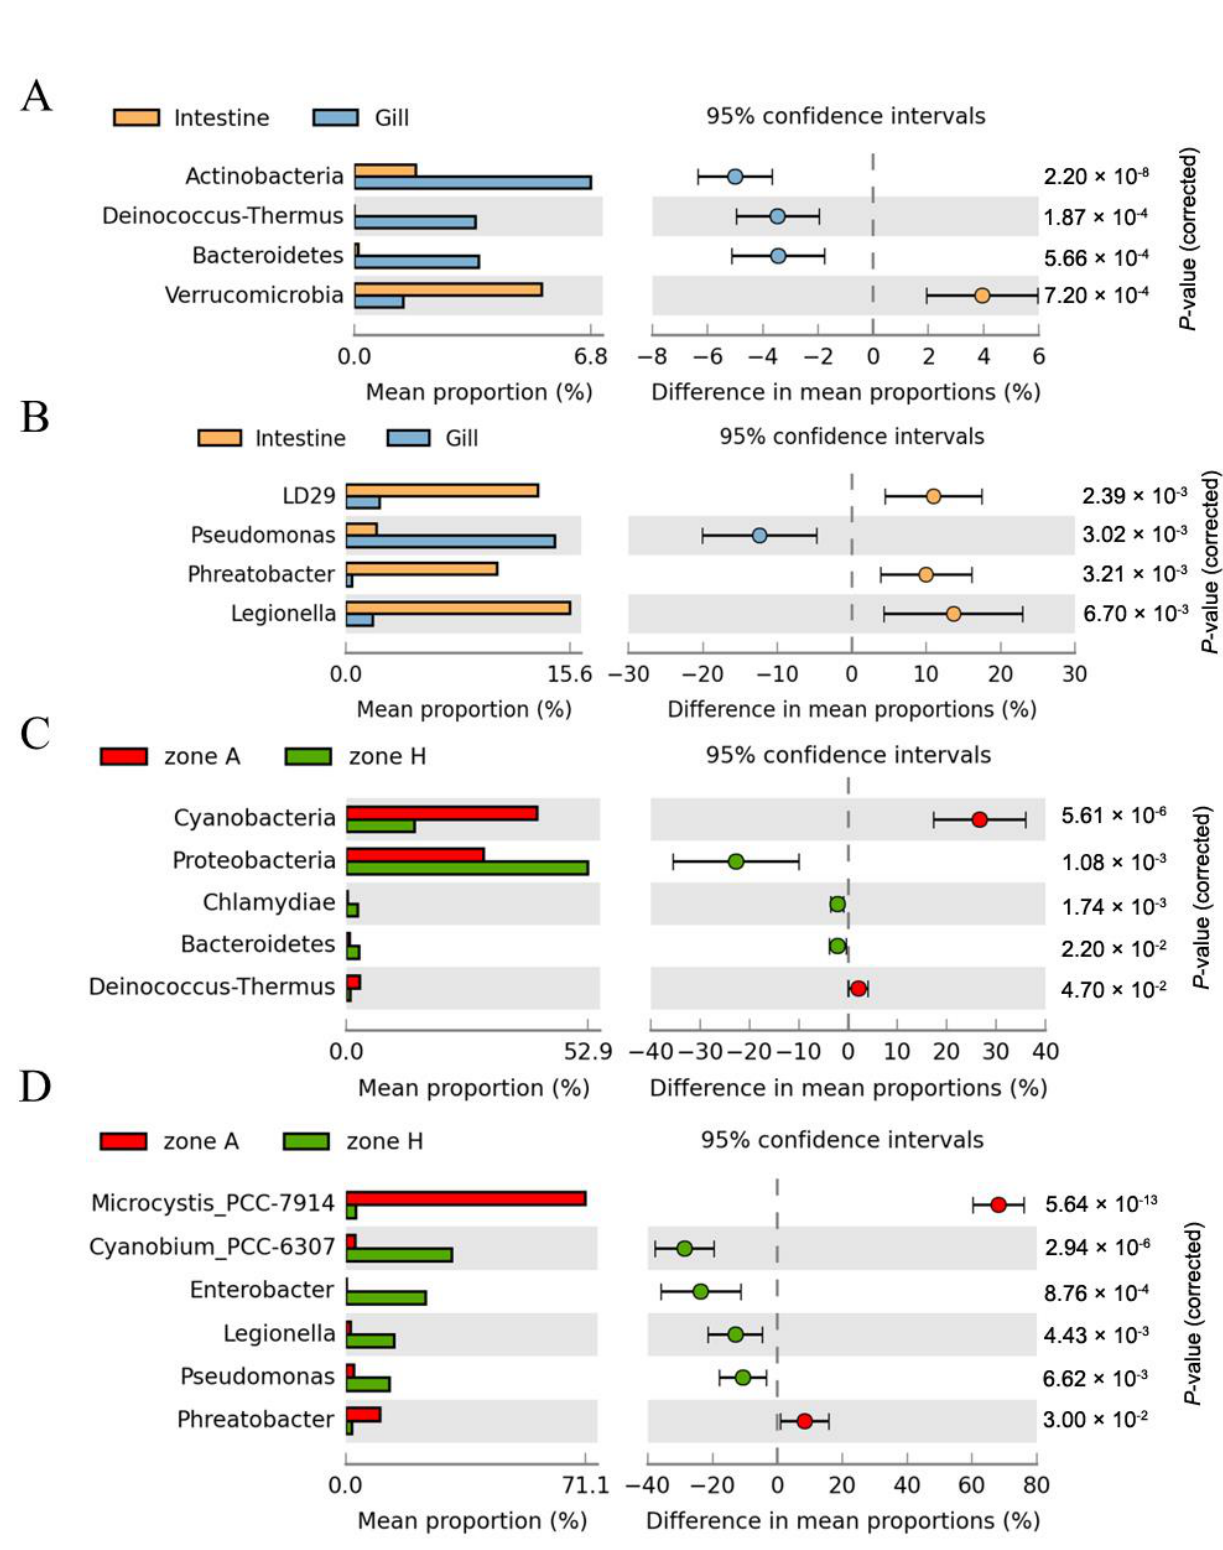
Figure 5. The difference in microbial composition between groups. ( A , B ) The microbial phyla ( A ) and genera ( B ) with significantly different abundances (>1%) between gills and intestines; ( C , D ) the microbial phyla ( C ) and genera ( D ) with different abundances (>1%) of fish from different habitats. The difference in abundances between the two groups was compared using Welch’s t -test.